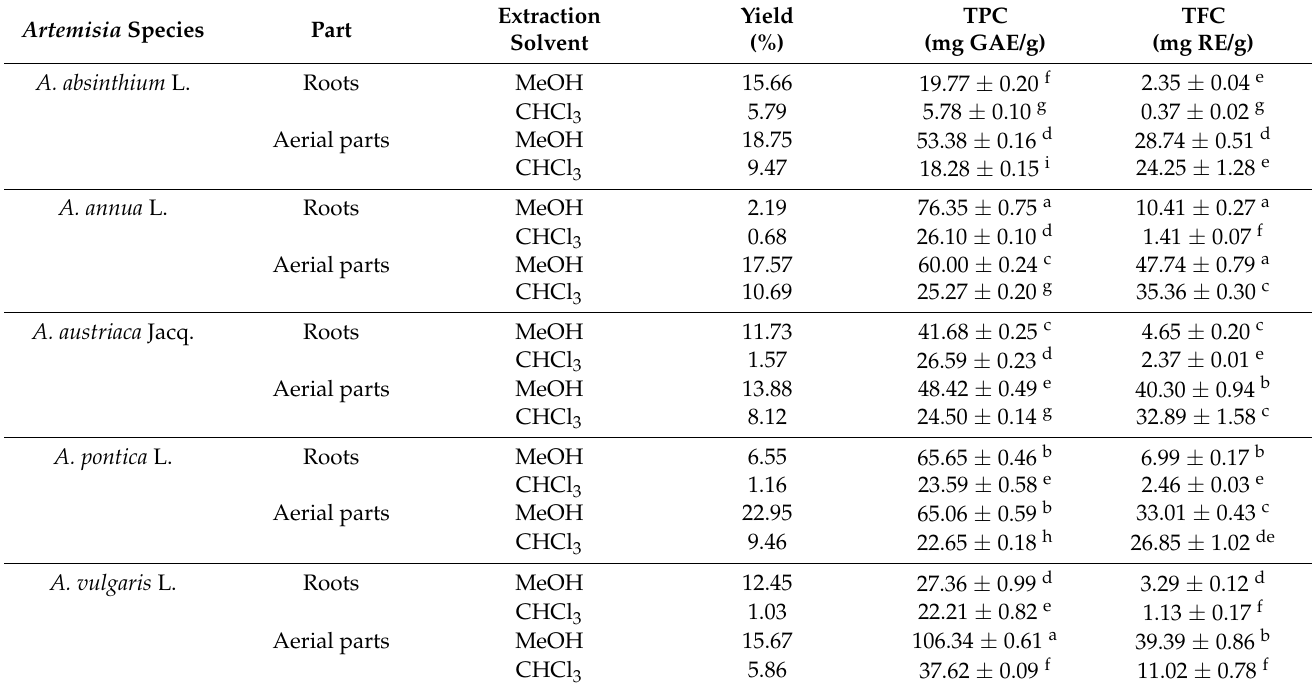
Table 1. Extraction yields and total phenolic and flavonoid contents of Artemisia spp. extracts. Extraction Artemisia Species Part